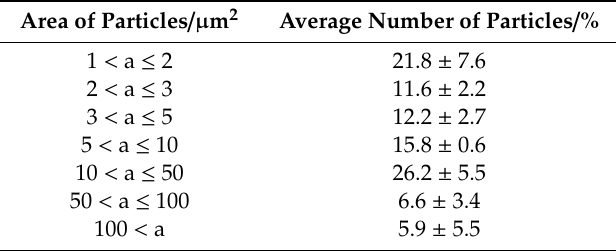
Table 4. Average measured area (a) of particles and average number of particles produced from an automotive pouch cell (at 100% SOC) at